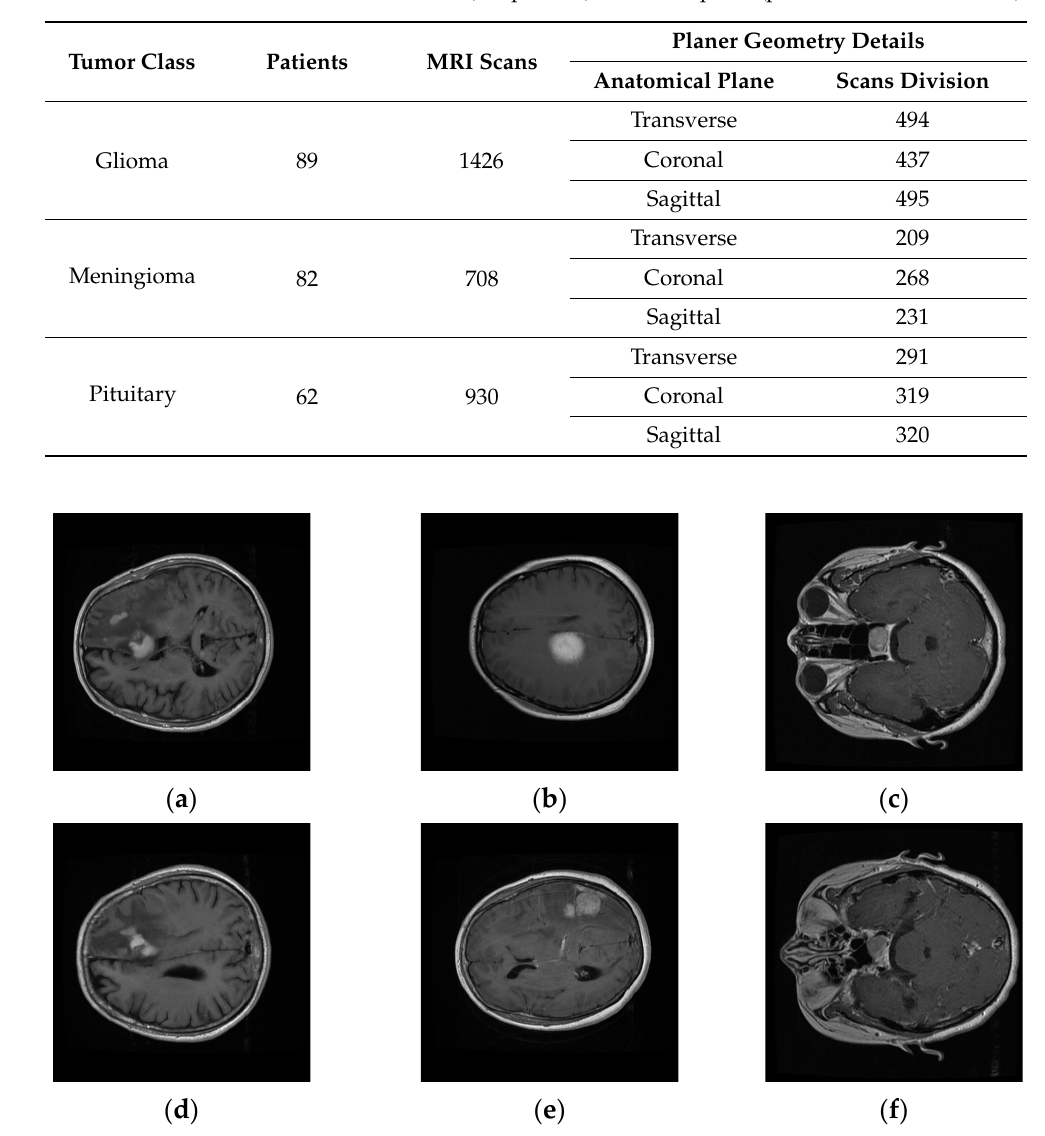
Table 1. CE-MRI dataset with 3064 instances (233 patients), 512 × 512 pixels (pixel: 0.49 mm × 0.49 mm).